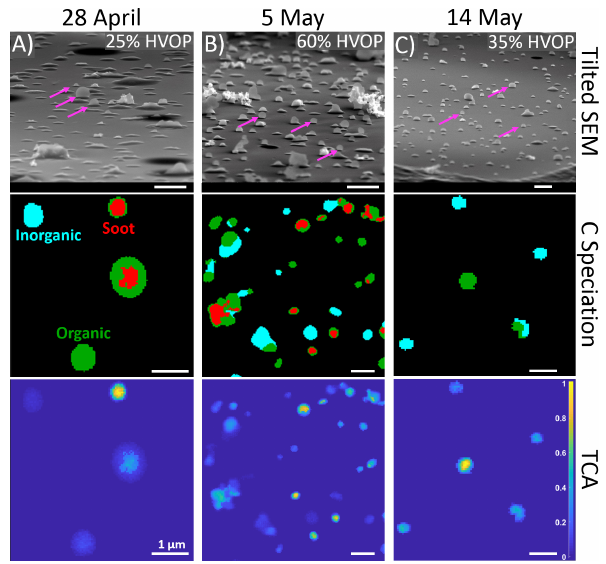
Figure 2. (Top row) Tilted (75 ◦ ) SEM images show differences in HVOP fractions between three samples. Each of these samples were collected on a MOUDI stage 8, which selected particles in the 150–360nm size range. Magenta arrows point to characteris- tic HVOPs. (Middle row) Carbon speciation maps with red repre- senting regions with enhanced C=C bonding, green representing or- ganics, and teal representing inorganics. (Bottom row) Total carbon absorption (TCA) images calculated from dividing thickness by the area equivalent diameter of each particle. The carbon speciation and TCA maps show the same fields of view. All scale bars are 1µm in